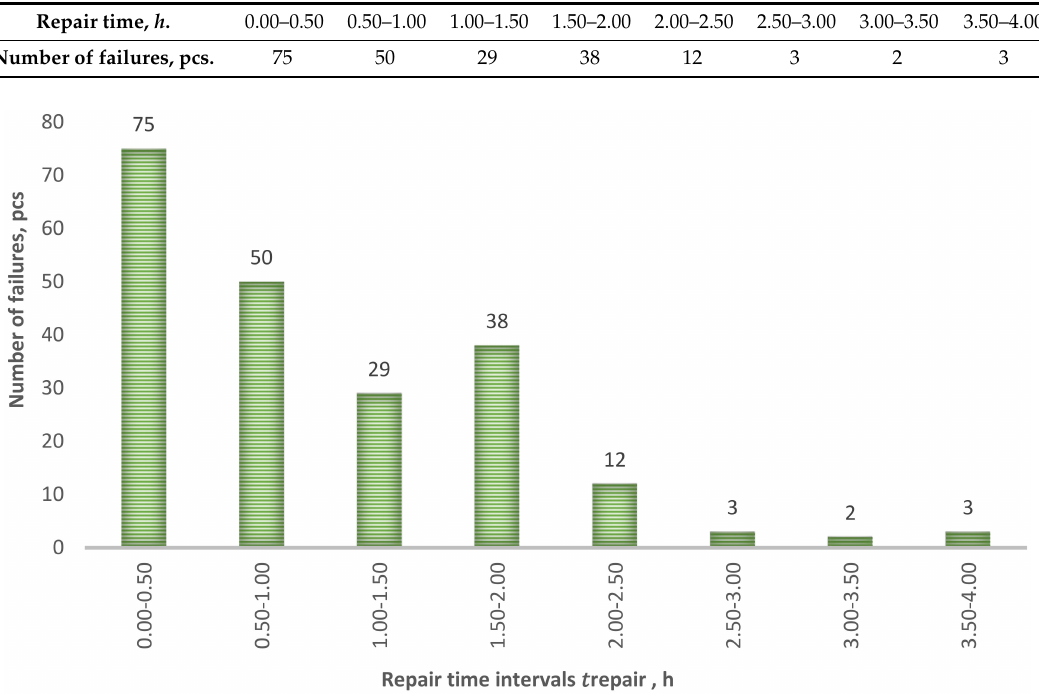
Figure 4. Number of failures for specific repair